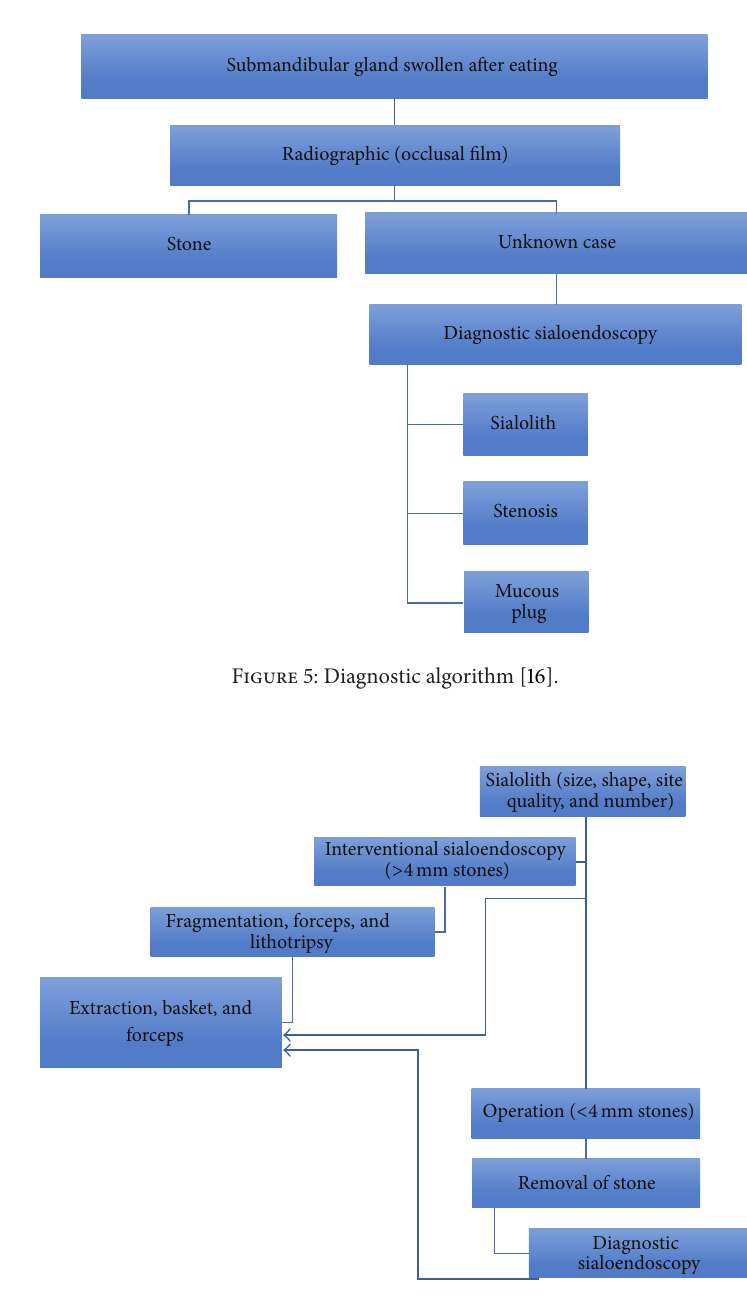
Figure 6: Therapeutic algorithm